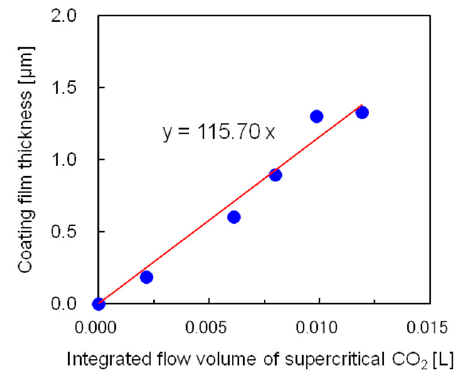
Figure 10. Dependence of the coating film thickness on the integrated flow volume of supercritical CO 2. at 40 °C and 25 MPa using the semi-flow coating method.